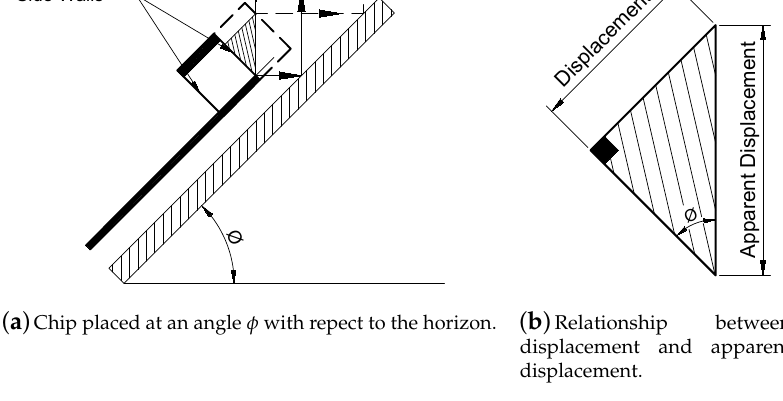
Figure 3. Measurement of in-plane